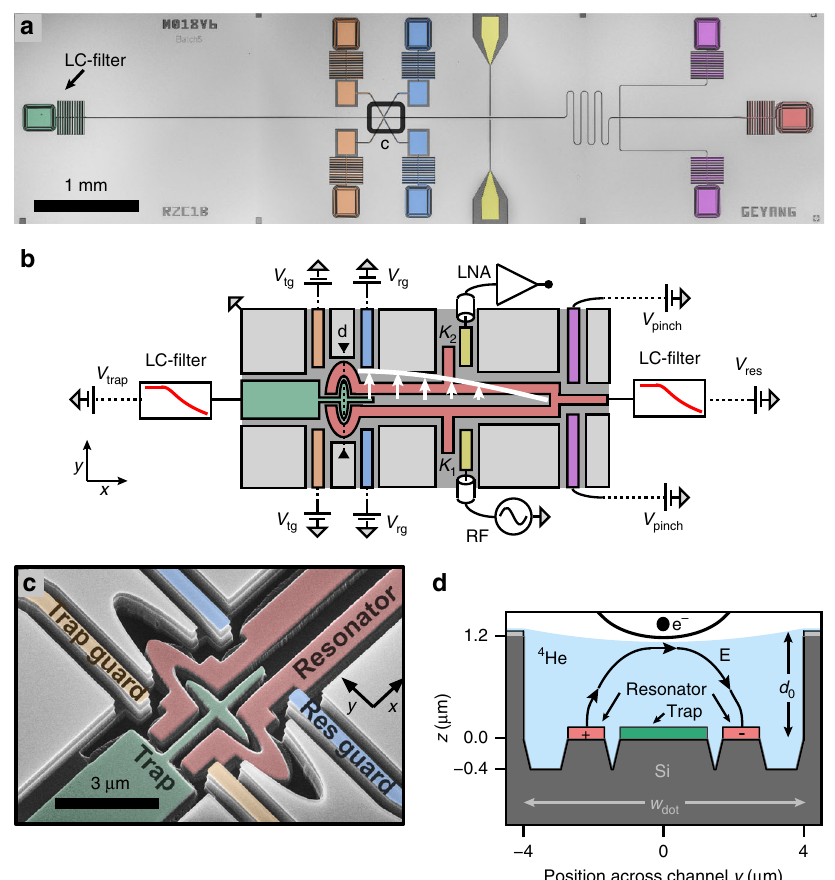
Fig. 1 An electron-on-helium dot a Optical micrograph and b schematic of the device. The resonator (red) can be probed with microwaves via coplanar waveguides (yellow) that couple (decay rates κ 1 ; 2 ) to the microwave resonator. The white arrows show the electric fi eld of the λ = 4 microwave mode at the center of the channel. The transmission is ampli fi ed with a low-noise ampli fi er (LNA). The electrostatic potential for electrons is controlled with additional electrodes, which are all equipped with individual low-pass fi lters to reject noise at the resonance frequency 28 (Supplementary Fig. 2). In b , we only show these fi lters for the trap and resonator. c Tilted, false-colored scanning electron micrograph of the dot showing the micro-machined silicon substrate. The resonator (red) and trap electrode (green) are located on the bottom of a micro-channel, which lies 1.2 μ m below the level of the resonator guards (blue), trap guards (orange) and ground plane. d Schematic cross-section of the dot shown in c , depicting the resonator center pins and trap electrode submersed in liquid helium. Electrons are trapped on the interface of liquid 4 He and vacuum by the electrostatic potential (solid black line) generated by electrodes near the dot. The electron orbital state couples to the transverse microwave electric fi eld E from the